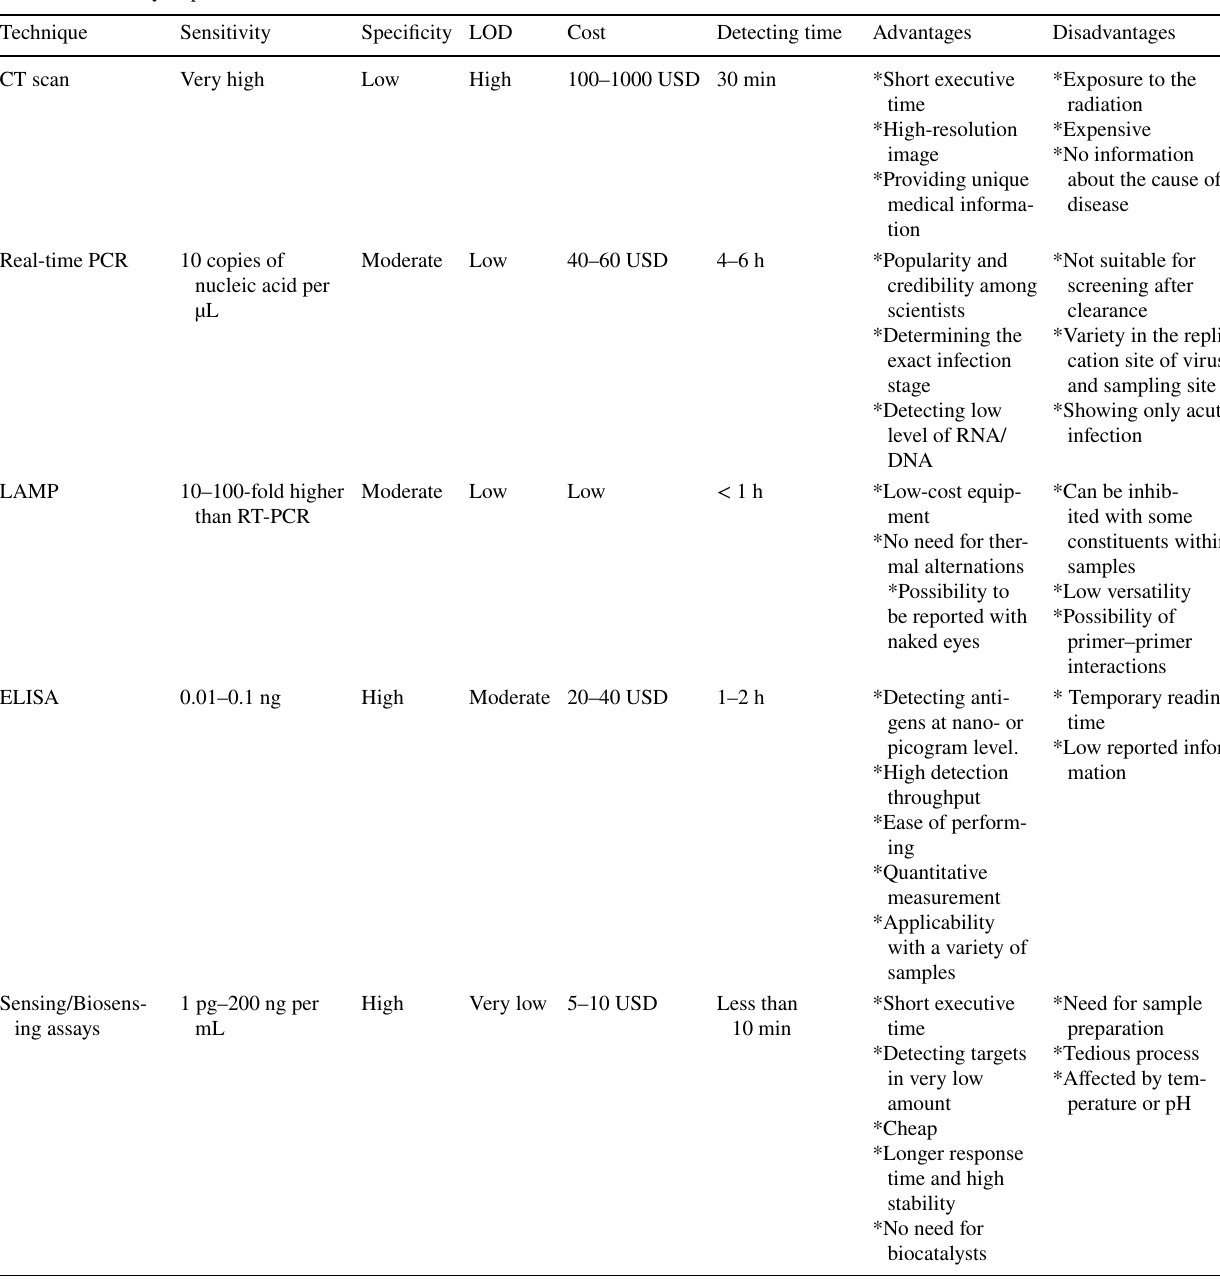
Table 2 Summary of presented methods for detection of coronaviruses